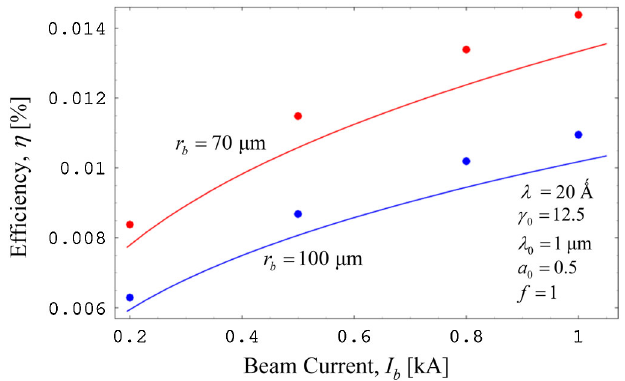
FIG. 4. (Color) X-ray conversion efficiency versus beam current for a cold electron beam, with electron beam radius r ¼ 100 (cid:1) m (blue). The curves are from Eq. (13) and (red) and r b the solid circles are from GENESIS simulations. The parameters are the same as in Fig. 2.